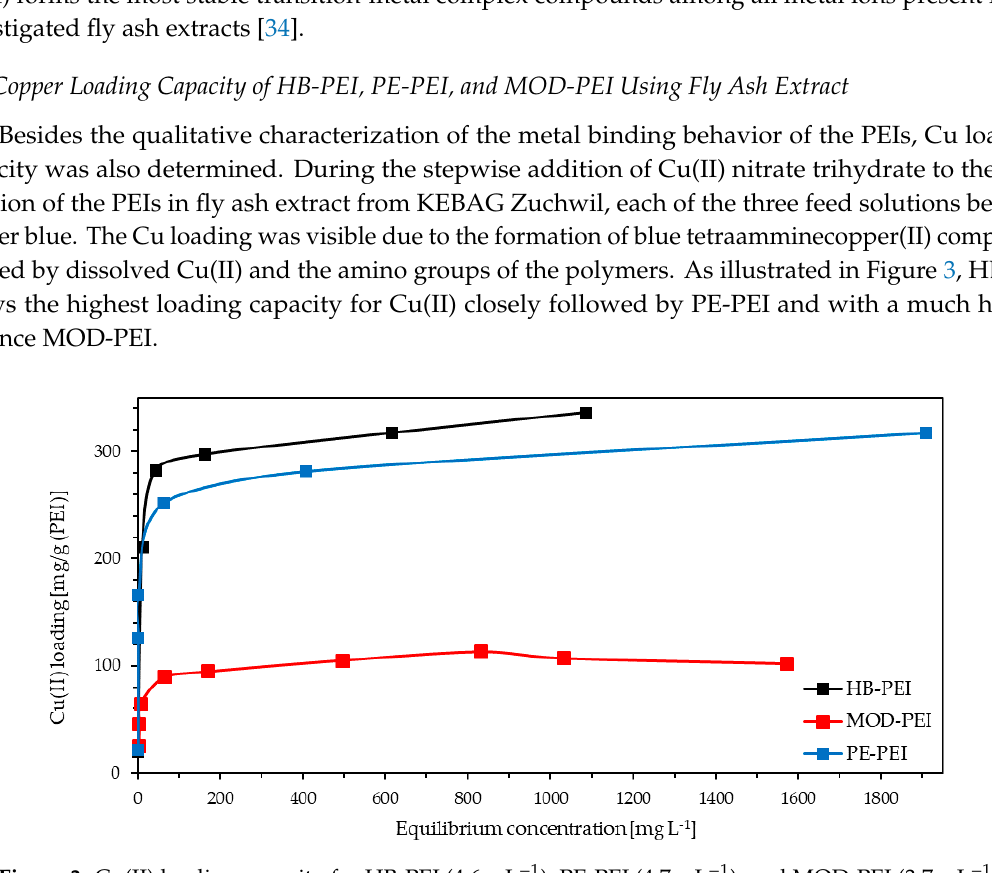
Figure 3. Cu(II) loading capacity for HB-PEI (4.6 g L − 1 ), PE-PEI (4.7 g L − 1 ), and MOD-PEI (3.7 g L − 1 ) using fly ash extract (KEBAG Zuchwil).